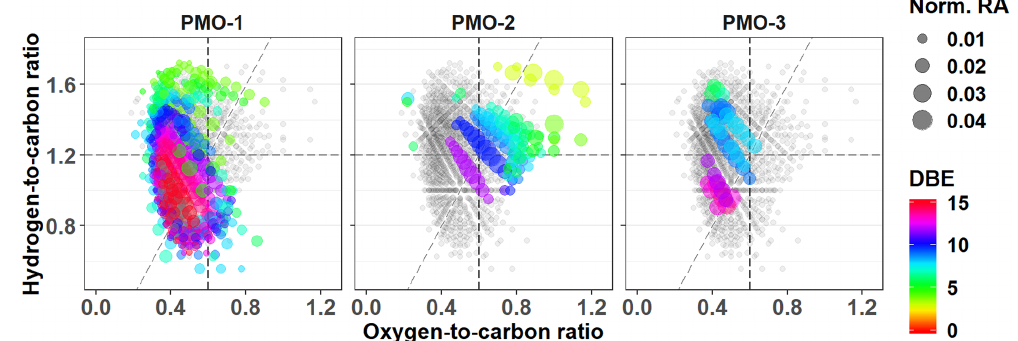
Figure 3. Van Krevelen plots for the CHNO species with all identified CHNO species (gray) and unique species (colored). The color represents the number of double bond equivalents (DBEs) in the corresponding molecular formula. The diagonal line is an oxidation line (OS C = 0 for C, H, O elements; Tu et al., 2016), where the more oxidized formulas are on the right side and less oxidized are on the